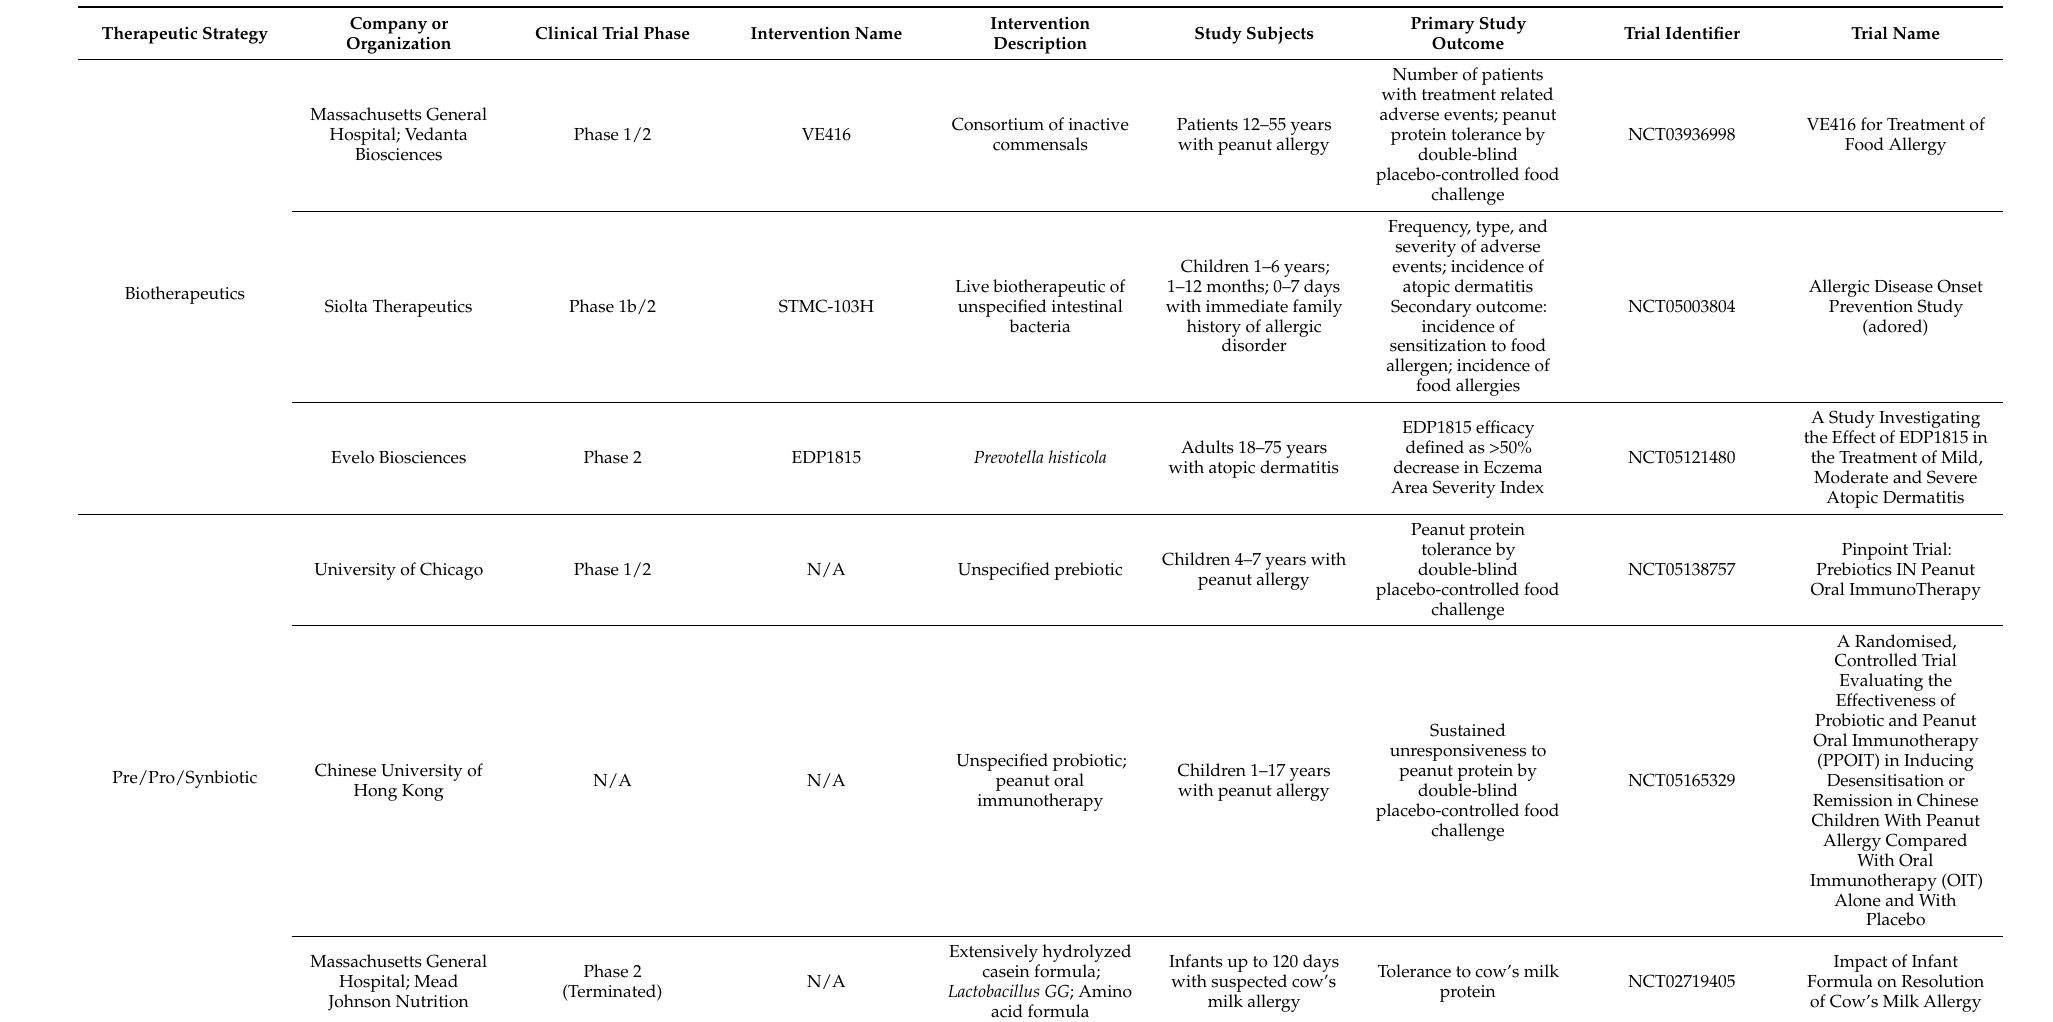
Table 2. Ongoing clinical trials of microbiome-related therapeutics for food